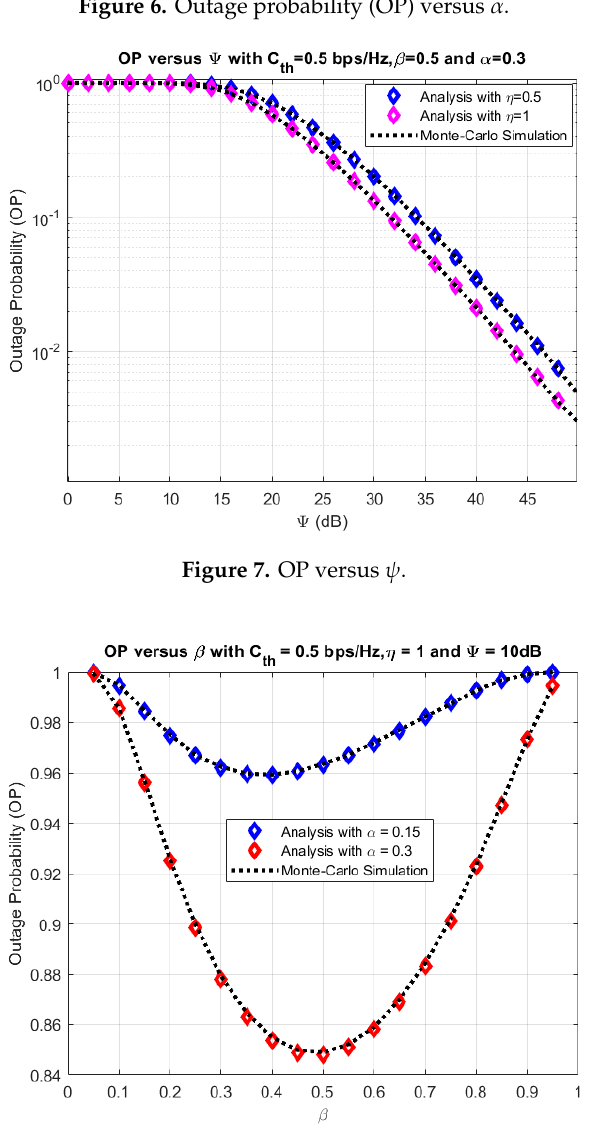
Figure 8. OP versus β .